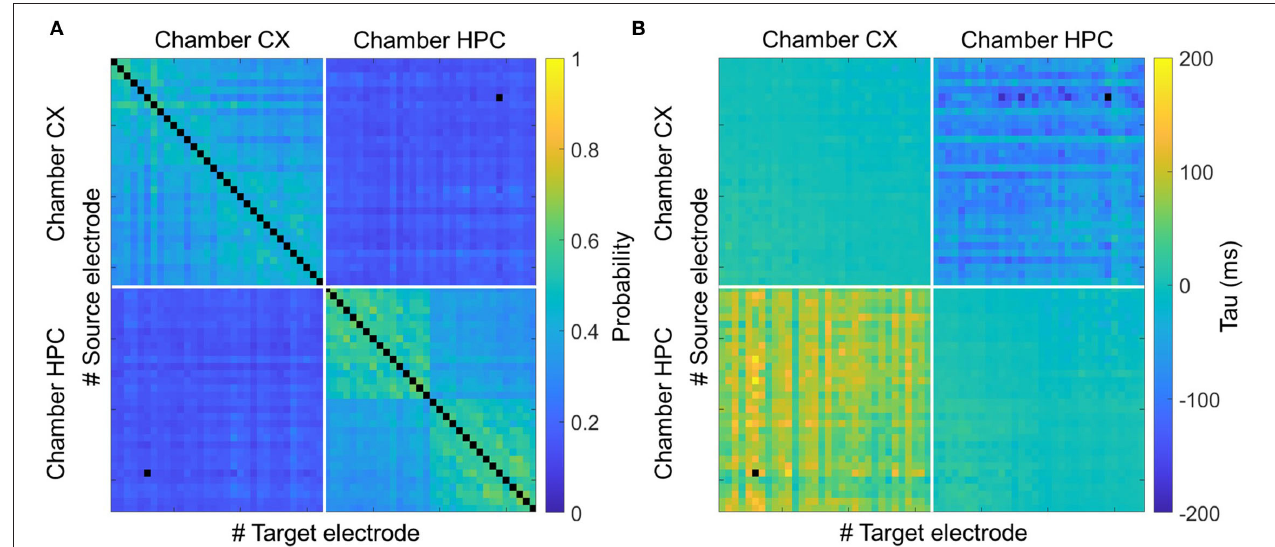
FIGURE 4 | Connectivity analysis of heterogeneous coculture models by cross-correlation. (A) Shows a heatmap of the averaged correlation amplitude (left) and (B) shows a heatmap of the correlation time lags (right) for pairs of spikes occurring in heterogeneous coculture models. The CX and HPC networks are each underlain by a multi-electrode array for recording. Each matrix cell represents the correlation of one pair of electrodes. Each analyzed electrode can be in either the CX or the HPC chamber, giving four types of correlation: chamber CX-to-CX (upper left), CX-to-HPC (upper right), HPC-to-CX (lower left), and HPC-to-HPC (lower right). The amplitude matrix shows the effect of the micro-tunnel barrier in reducing interactions between networks, and the time-lag matrix shows that spikes in the HPC network lead to those in the CX network.